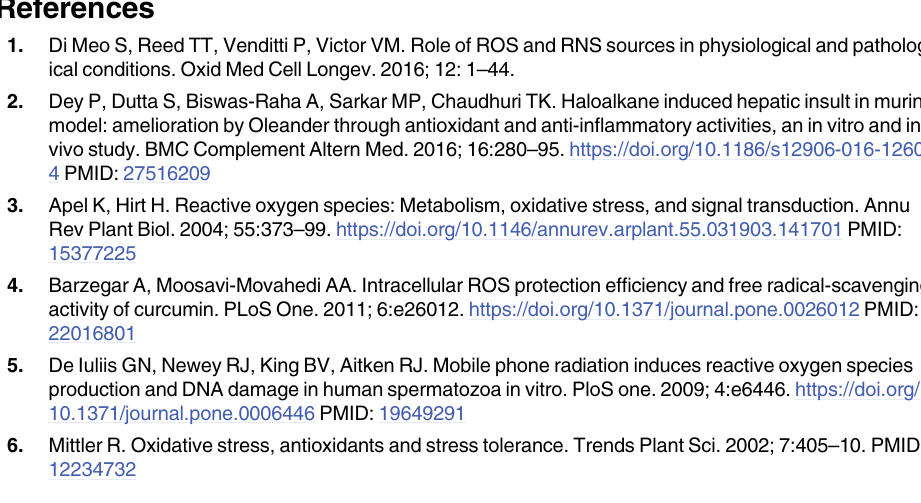
S3 Fig. Molecular docking image. Molecular docking (molecular surface view) between NF κβ protein and Campesterol. S1 Table. IC values of Croton bonplandianus (CBL) and standard for different antioxi- 50 dant and free radical scavenging assays. S2 Table. Describe the effect of CBL on liver histology parameters of the CCl injured liver. S3 Table. Chemical fingerprint of CBL extract revealed by GC-MS